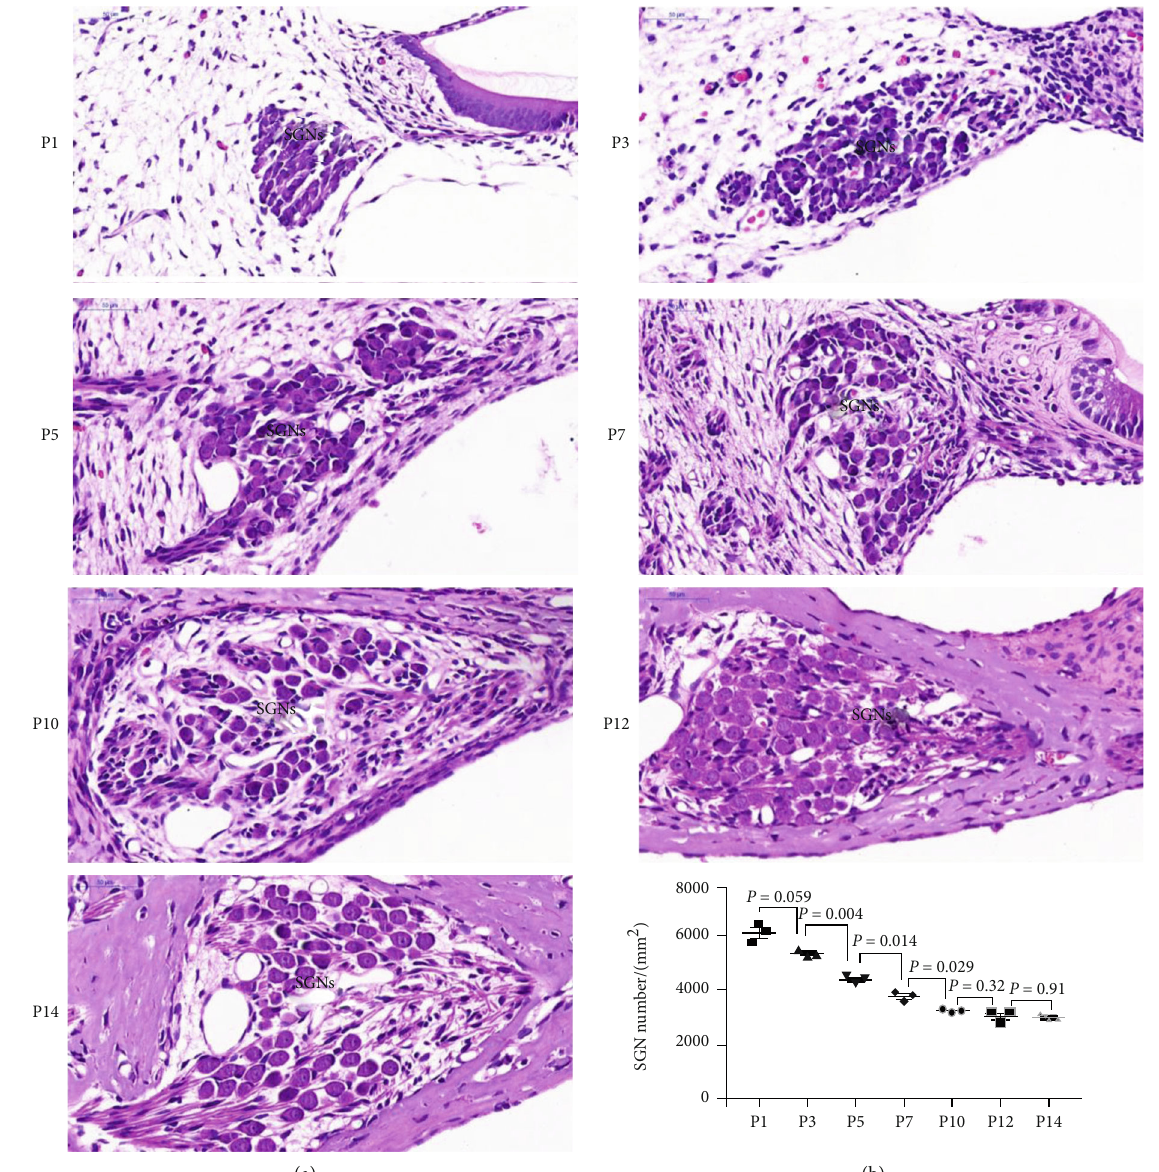
Figure 1: HE staining of SGNs during postnatal weeks from P1 to P14. The SGNs are obtained from the middle turn of the rat cochlea. The immature neurons and glial cells were basophilic and are indicated by blue staining from P1 to P5. The Schwann cells at P12 and P14 were adhered and surrounded by neurons. In the fi rst postnatal week, the density of SGNs was decreased by about 33% and was stabilized in the second week. Scale bars = 50 μ m. The number/mm 2 of SGNs was counted and is shown at the lower part of